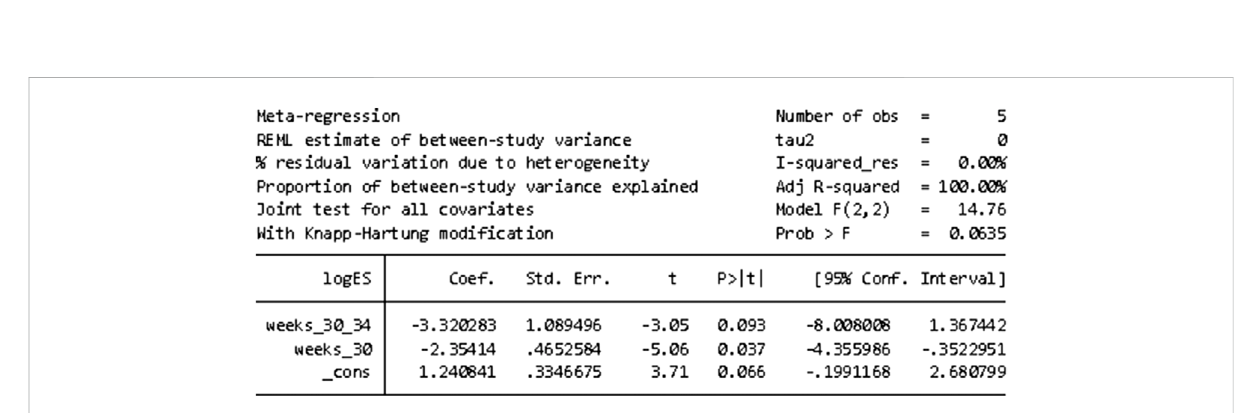
FIGURE 7 Results of meta-regression to fi nd the cause of heterogeneity in the incidence of adverse events.